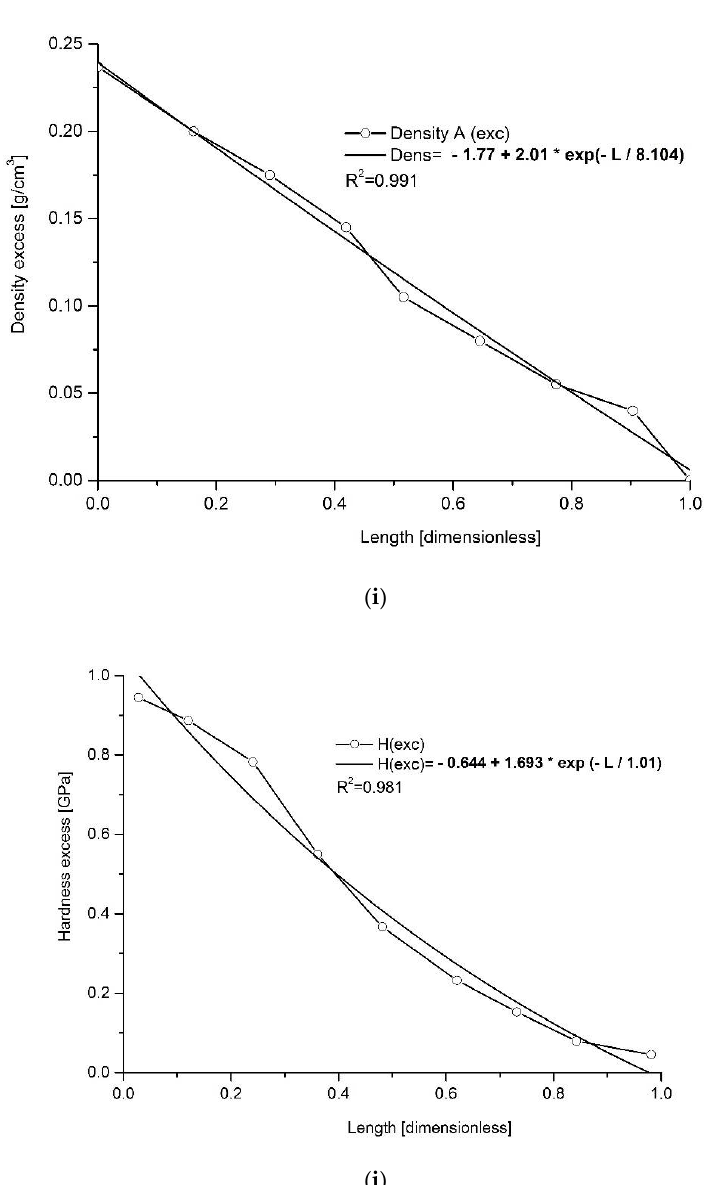
Figure 2. Approximation of the excessive chemical spatial profiles along the human molar enamel with exponential functions for ( a ) Ca; ( b ) P; ( c ) Cl; ( d ) Mg; ( e ) Na; ( f ) K; ( g ) F; ( h ) CO 32− , all expressed in weight per cents and for ( i ) density and ( j ) hardness excesses—adopted from [44,46], respectively.